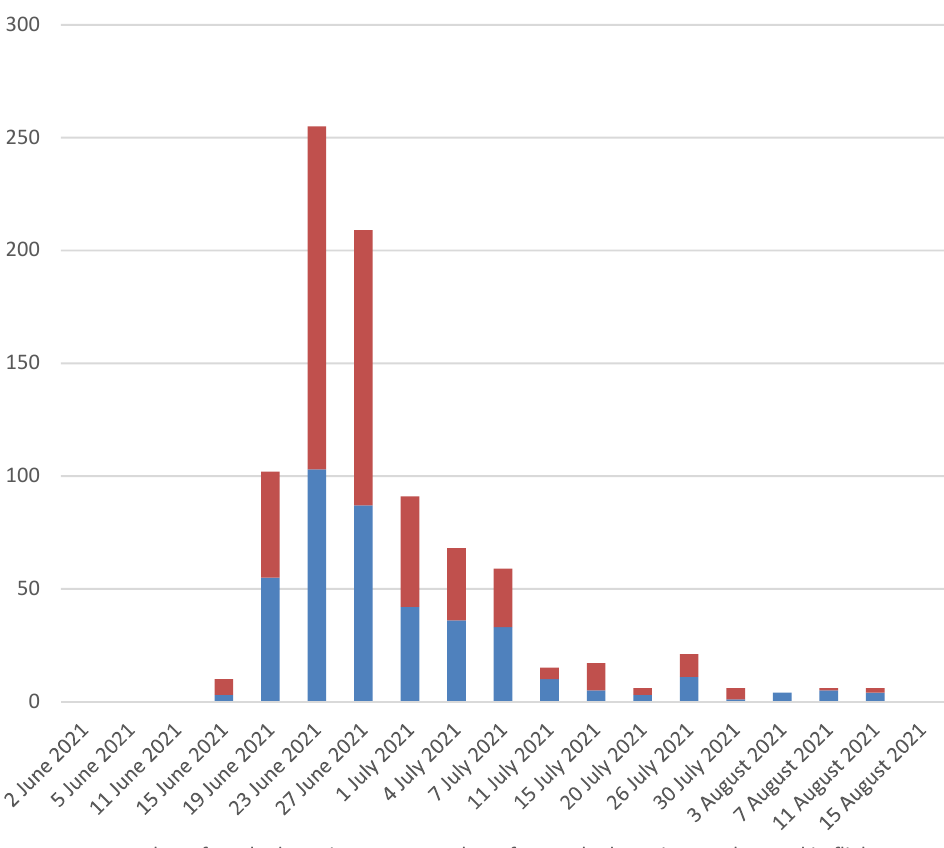
Figure 9. Flight time of Cordulegaster heros in the Habešský potok stream (Kostelany cadastral territory, southern Czech Republic) (locality VIe) in 2021.